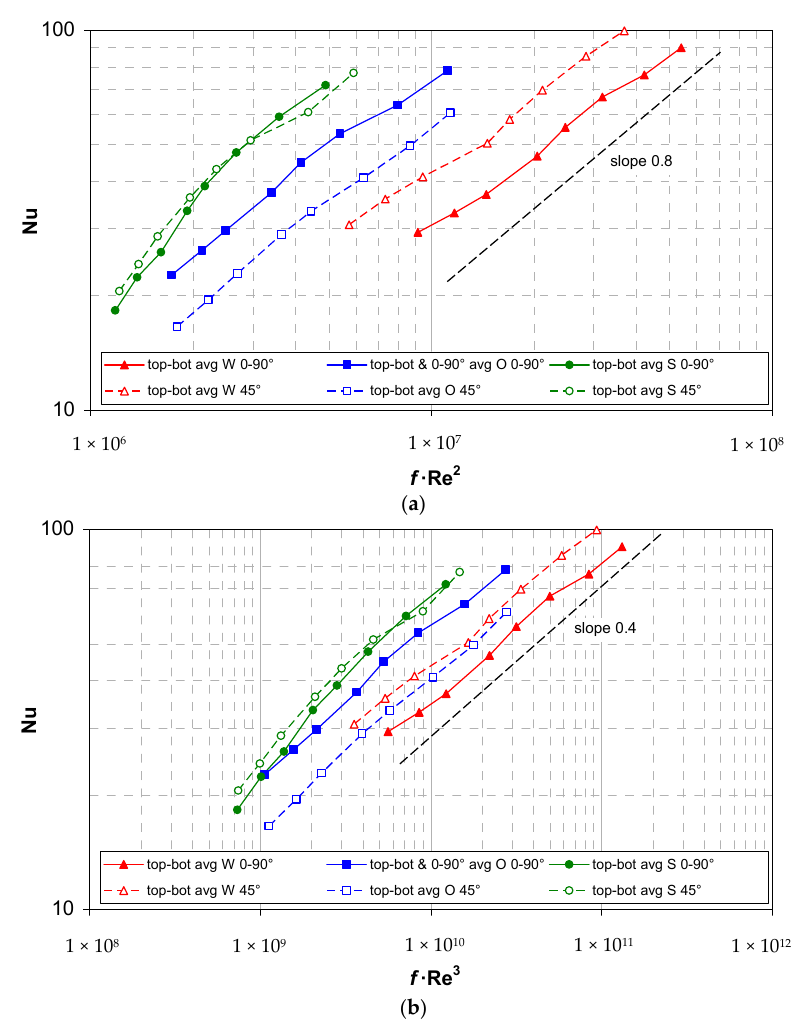
Figure 9. Experimental mean Nusselt number (top-bottom averaged) as a function of the pressure number f ·Re 2 ( a ) or the power number f ·Re 3 ( b ) for all the spacer configurations investigated.